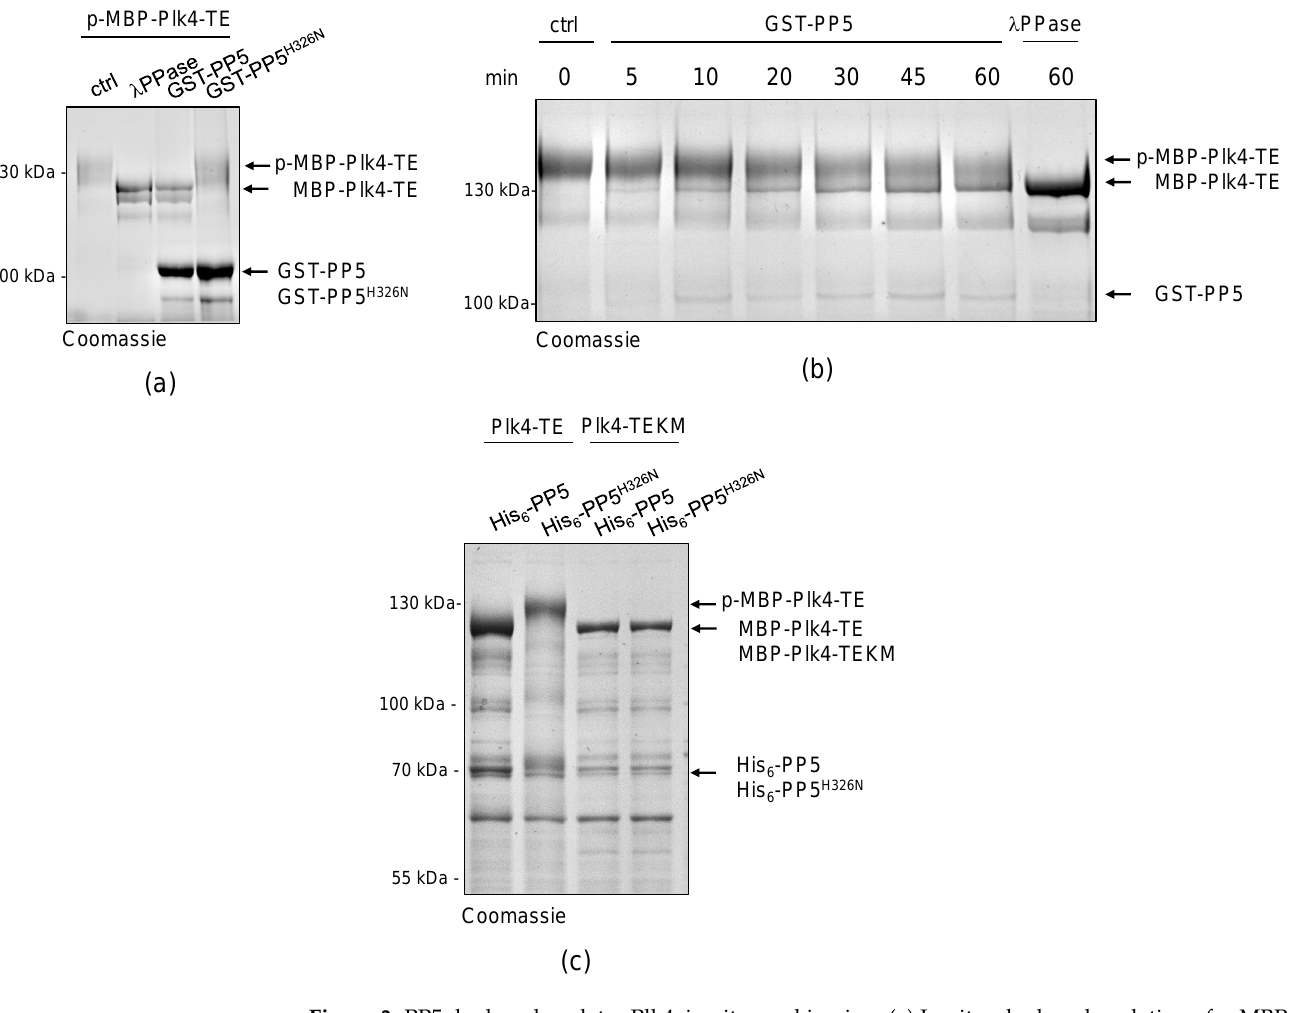
Figure 3. PP5 dephosphorylates Plk4, in vitro and in vivo. ( a ) In vitro dephosphorylation of p-MBP- Plk4-TE (“p-” refers to the self-phosphorylated, while “TE” refers to the T172E activating mutation in Plk4, respectively) was tested by gel-shift assay. The electrophoretic mobility of the phosphorylated forms is decreased, therefore they run higher, while the dephosphorylated species run lower in a long preparative SDS-PAGE. Purified recombinant p-MBP-Plk4-TE is efficiently dephosphorylated by the λ -phosphatase ( λ PPase) and GST-PP5, in vitro. GST-PP5 H326N serves as the negative control; “ctrl” refers to non-treated purified kinase. ( b ) The GST-PP5-mediated dephosphorylation kinetics of p-MBP-Plk4-TE is presented by Coomassie brilliant blue-stained preparative SDS-PAGE. Incubation times (minutes) are indicated. λ PPase serves as the positive control; “ctrl” refers to non-treated sample. ( c ) In vivo dephosphorylation of Plk4 in bacteria was tested by gel-shift assay. MBP-Plk4-TE or its kinase dead (TEKM) version were co-expressed with His 6 -PP5 or its inactive form, His 6 - PP5 H326N , respectively, in bacteria. Crude cell lysates were analyzed by SDS-PAGE, which shows that MBP-Plk4-TE dephosphorylation requires the active His 6 -PP5, in vivo. MBP-Plk4-TEKM is not capable of self-phosphorylation. His 6 -PP5 H326N is unable to dephosphorylate Plk4. In a similar experimental setup, we tested the ability of MBP-Plk4-TE to modify the STAN motif in GST-Ana2 281 − 420aa , a prerequisite for Sas6 binding to the protein [32]. We showed that in all cases, immobilized GST-Ana2 281 − 420aa treated with the purified kinases was capable of Sas6-binding, and it was independent of PP5’s activity (Figure 4b). This means, that the PP5-dephosphorylated MBP-Plk4-TE is able to modify the STAN motif, and promote Sas6-binding to the immobilized Ana2, in